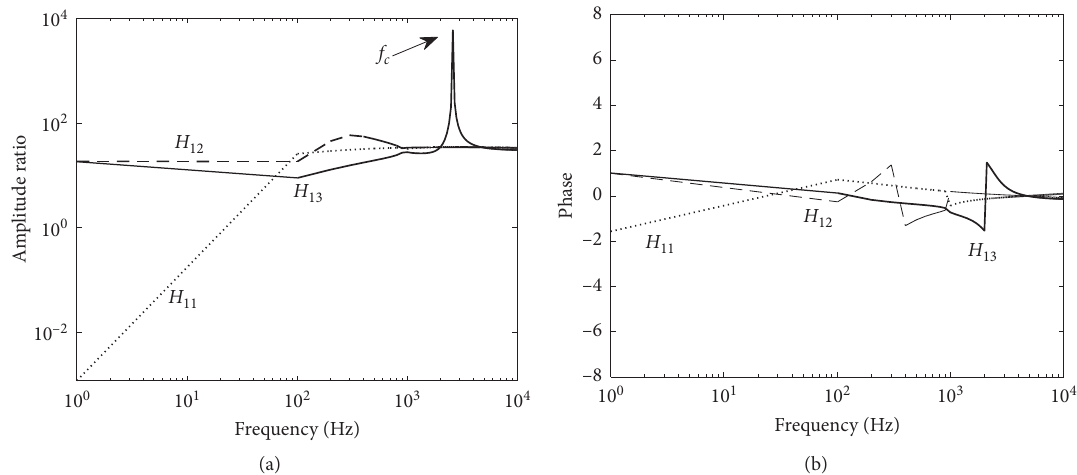
Figure 6: Amplitude ratio and phase of the transverse displacement to the rotation angle for the curved beam (a) and amplitude ratio (b) phase.